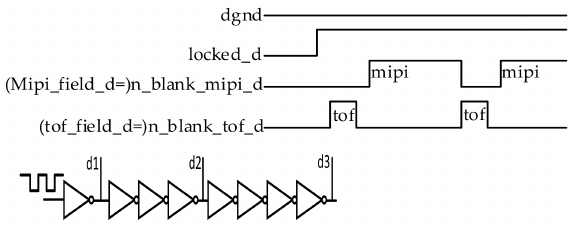
Figure 14. Inverter chain delay (0.3–0.9 ns).